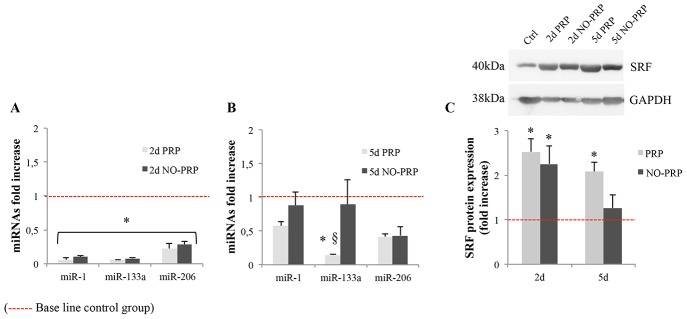
Real time-PCR analysis of miR-1, miR-133a and miR-206 expression using total RNA isolated from Ctrl-, PRP- and NO-PRP- group at 2 (A) and 5 (B) day post-injury.C) Western blot analysis of SRF protein expression in skeletal muscle at 2- and 5-day post-injury. The histograms represent fold change expression calculated as means ± SEM (n = 5 rats/group at each time point) respect to the Ctrl group. *p<0.05 vs. Ctrl group. §p<0.05 vs. 5d NO-PRP group. Dashed line represents the base line Ctrl group.